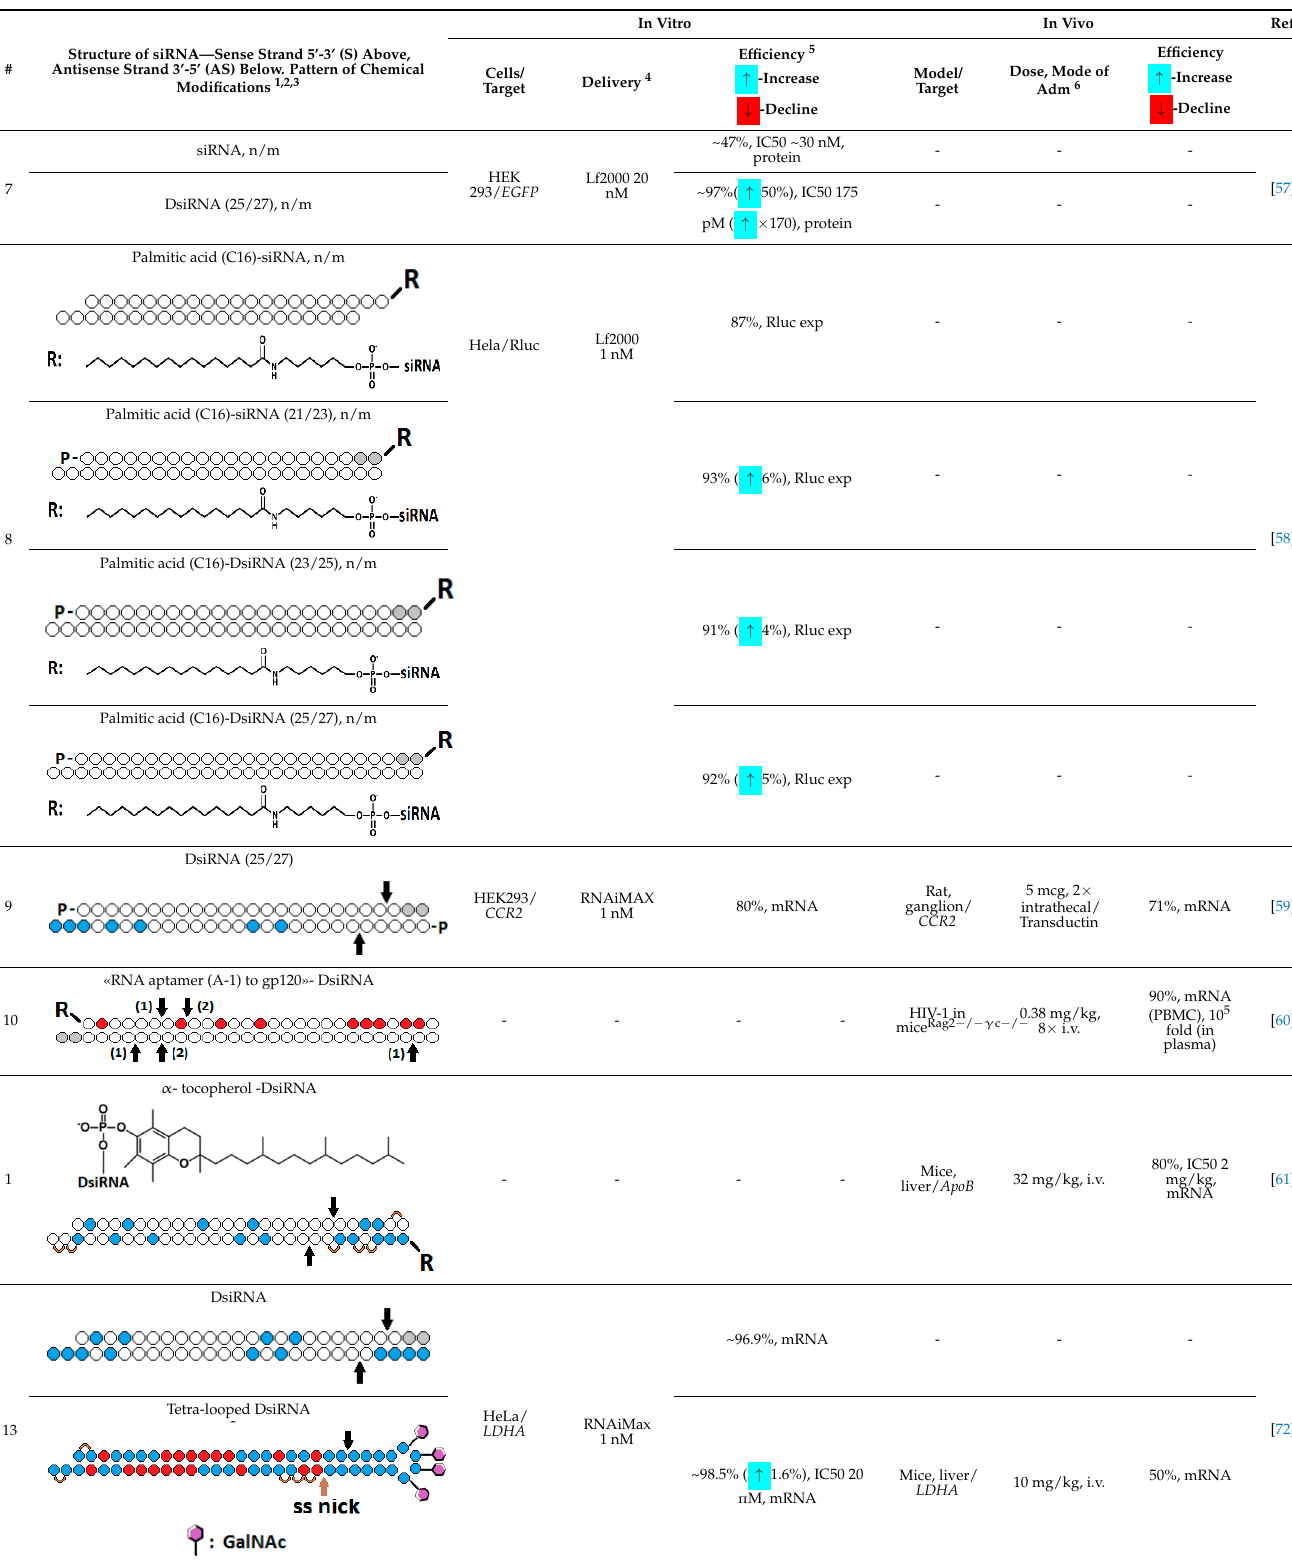
Table 3. Structural modifications of DsiRNA.